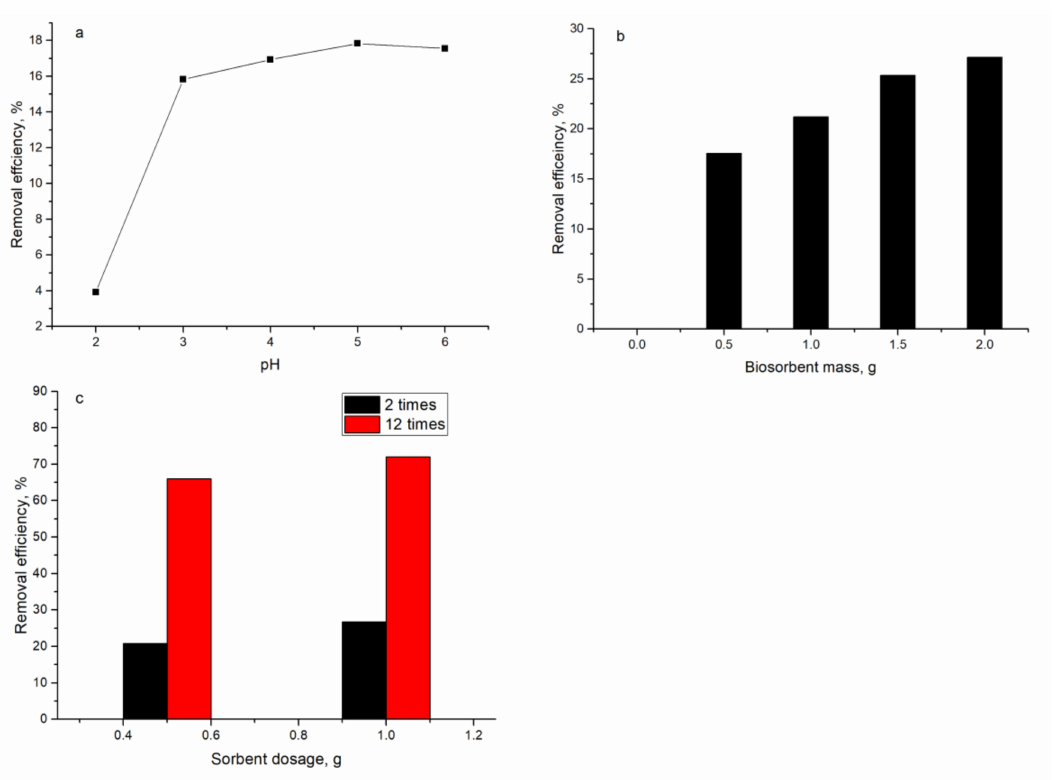
Figure 10. E ff ect of di ff erent parameters on Ni(II) removal from industrial e ffl uent: ( a ) pH, ( b ) sorbent dosage (initial e ffl uent), ( c ) sorbent dosage (diluted e ffl